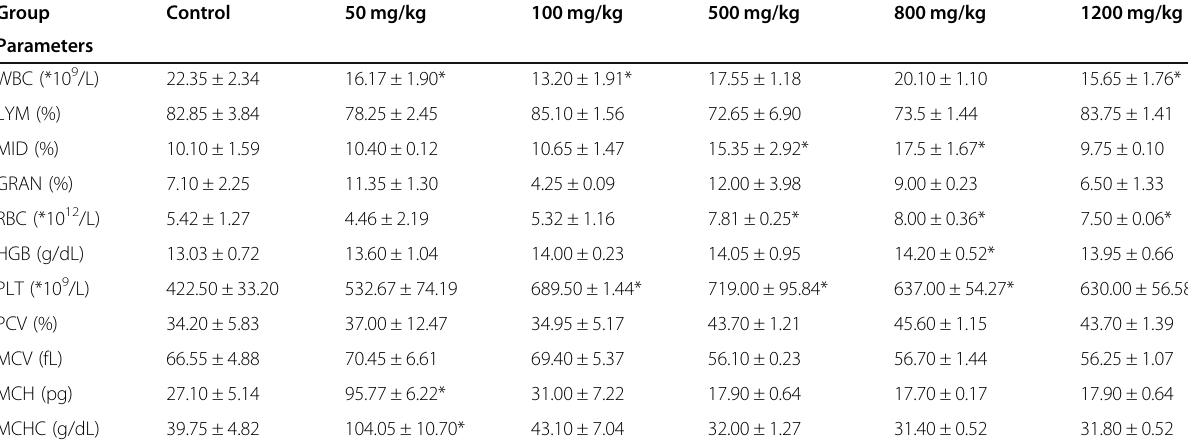
Table 3 Effects of ethanol extracts of J. carnea leaf on hematology parameters Group Control